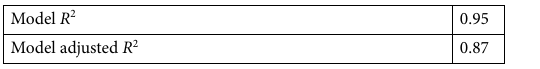
Table 4. ANOVA regression statistics for Box-Behnken design.